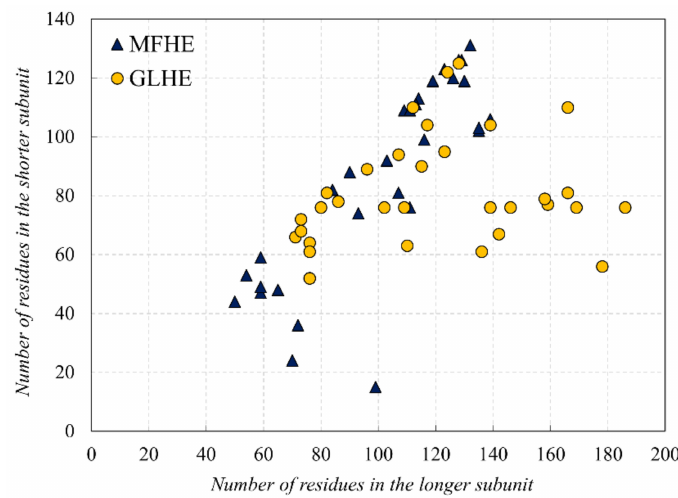
Figure 1. Comparison of the subunit lengths of the Mutual Synergistic Folding (MSF) (MFHE—blue triangles) and globular (globular heterodimeric GLHE—yellow dots) heterodimeric